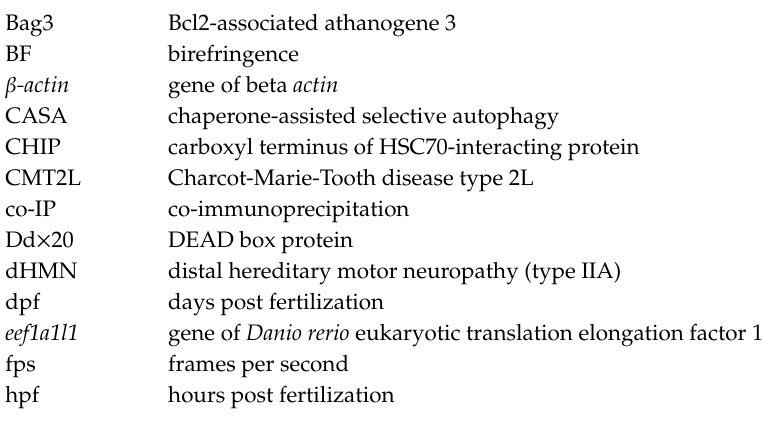
Figure S1: Control of morpholino-mediated hspb8 knockdown e ff ectiveness in 72 hpf zebrafish embryos. Figure S2: Control of the specificity of a commercially available monoclonal antibody raised against human Hspb8 used in this study for the detection of zebrafish